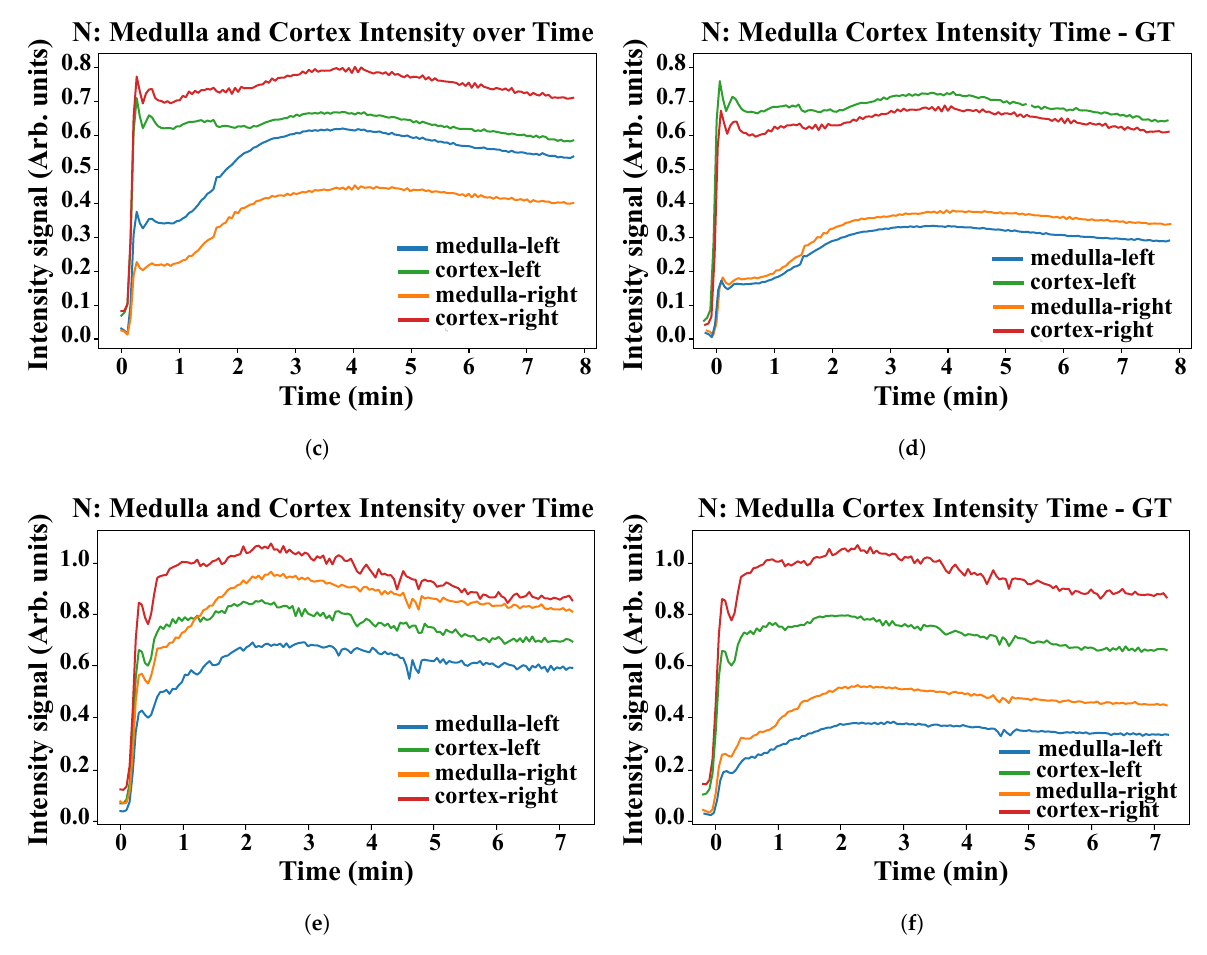
Figure A1. Graphs ( a – f ) represent the time–intensity curves of three clinically “normal” cases (scans or 4D volumes). The first column shows the relative contrast intensity enhancement of the automatic renal compartment segmentation in both the left and right kidneys over time (minutes). The second column shows the corresponding ground-truth (GT) time–intensity curves.